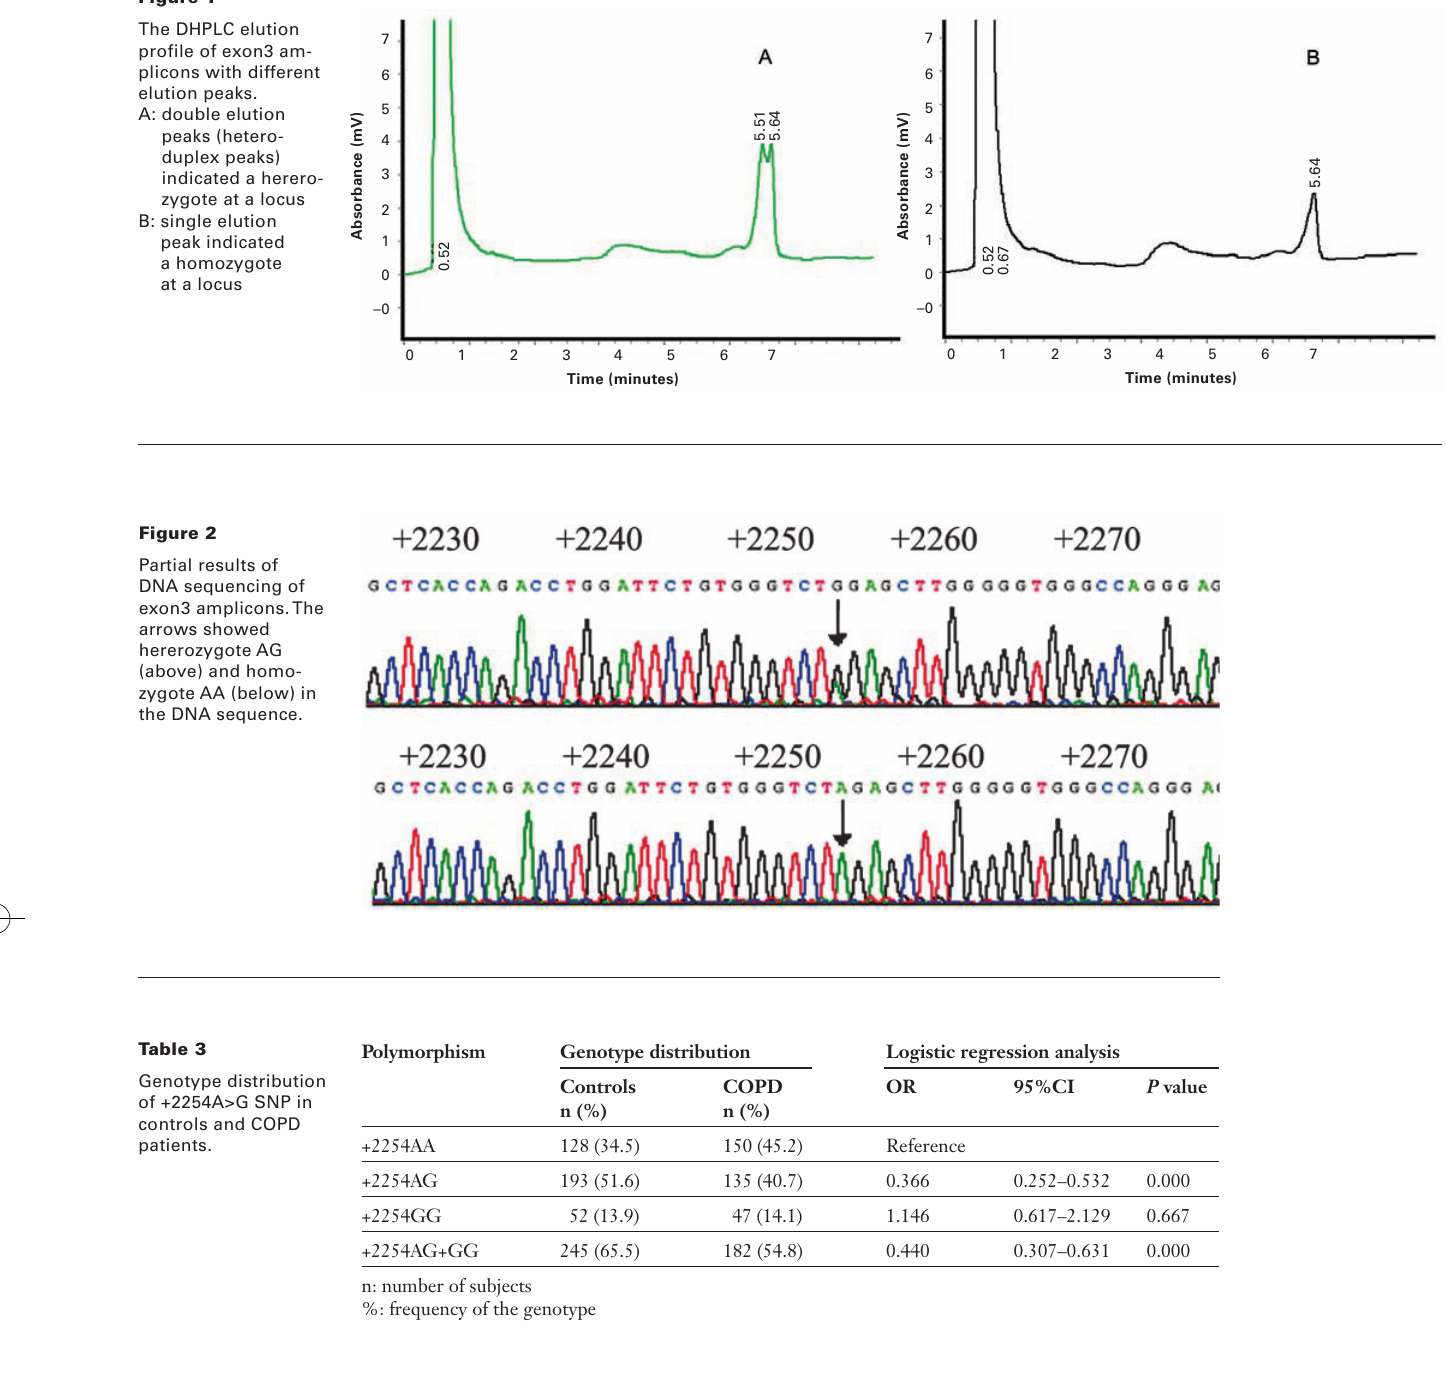
Spirometric classifi- cation of COPD sever- ity based on post- bronchodilator FEV 1 according to GOLD